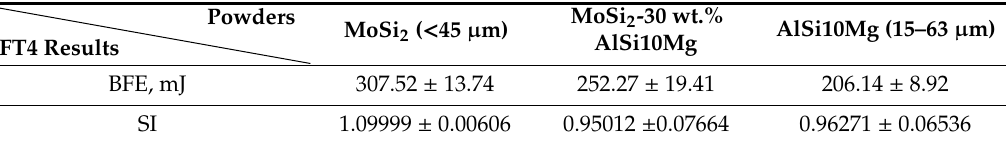
Table 4. Average flow rate for the MoSi 2 , MoSi 2 -30 wt.% AlSi10Mg, and AlSi10Mg alloy powders.